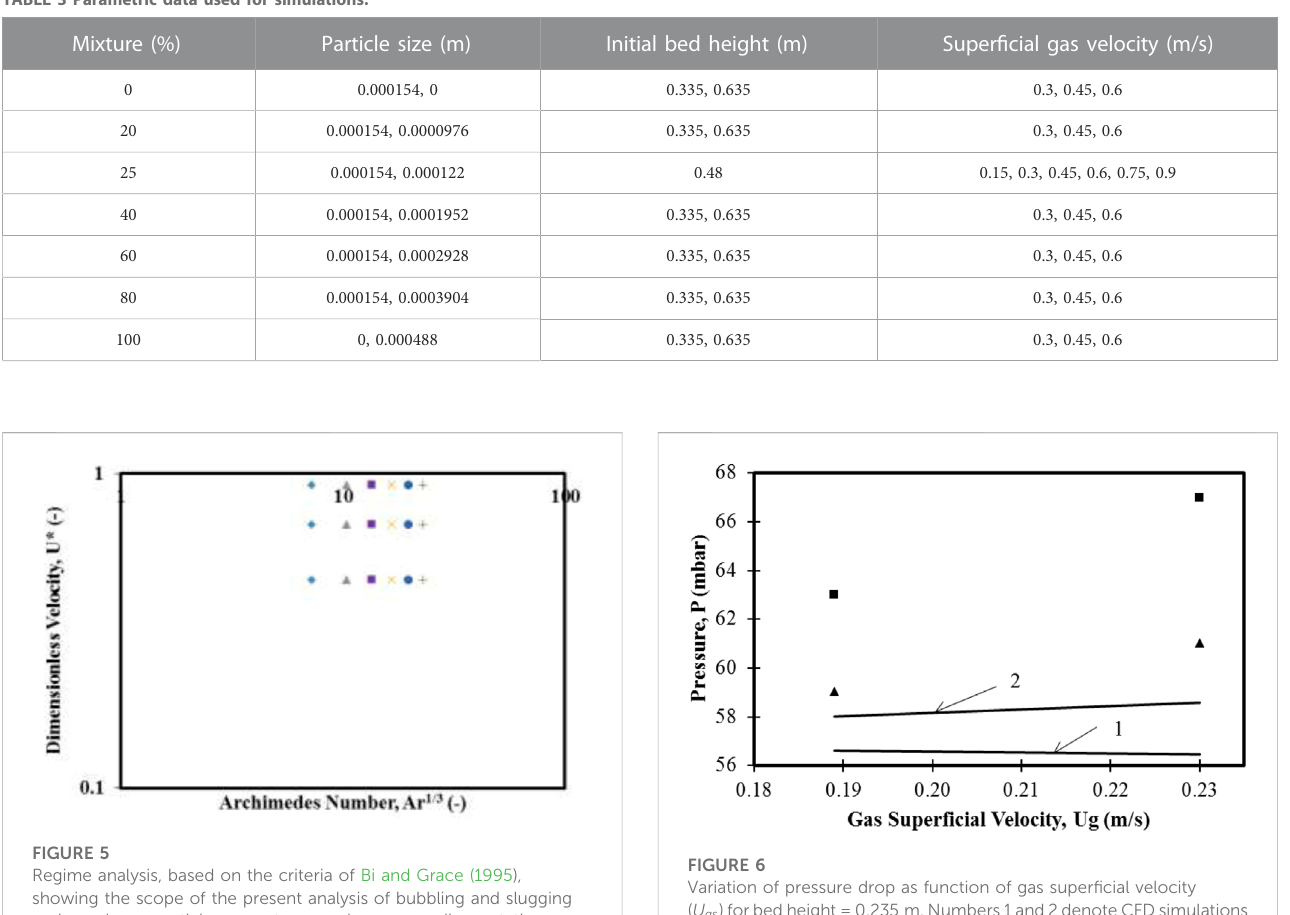
TABLE 3 Parametric data used for simulations.